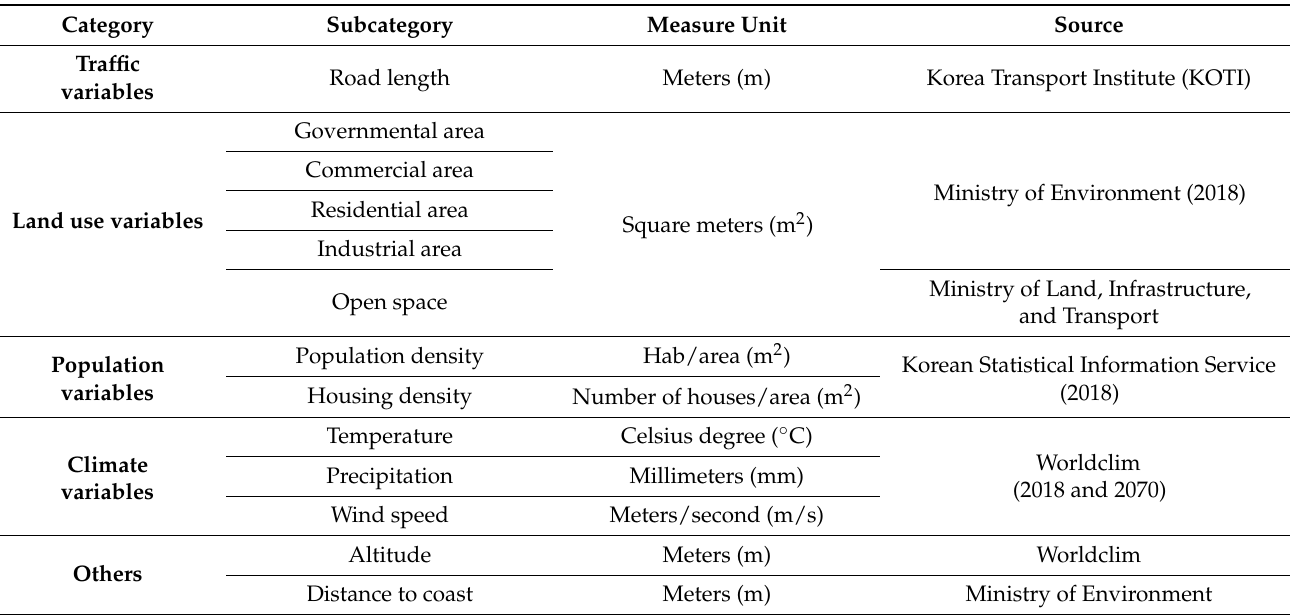
Table 1. Categories and Subcategories of Predictor variables collected. Every variable corresponds to the year 2018 and was rescaled into spatial resolution of 30